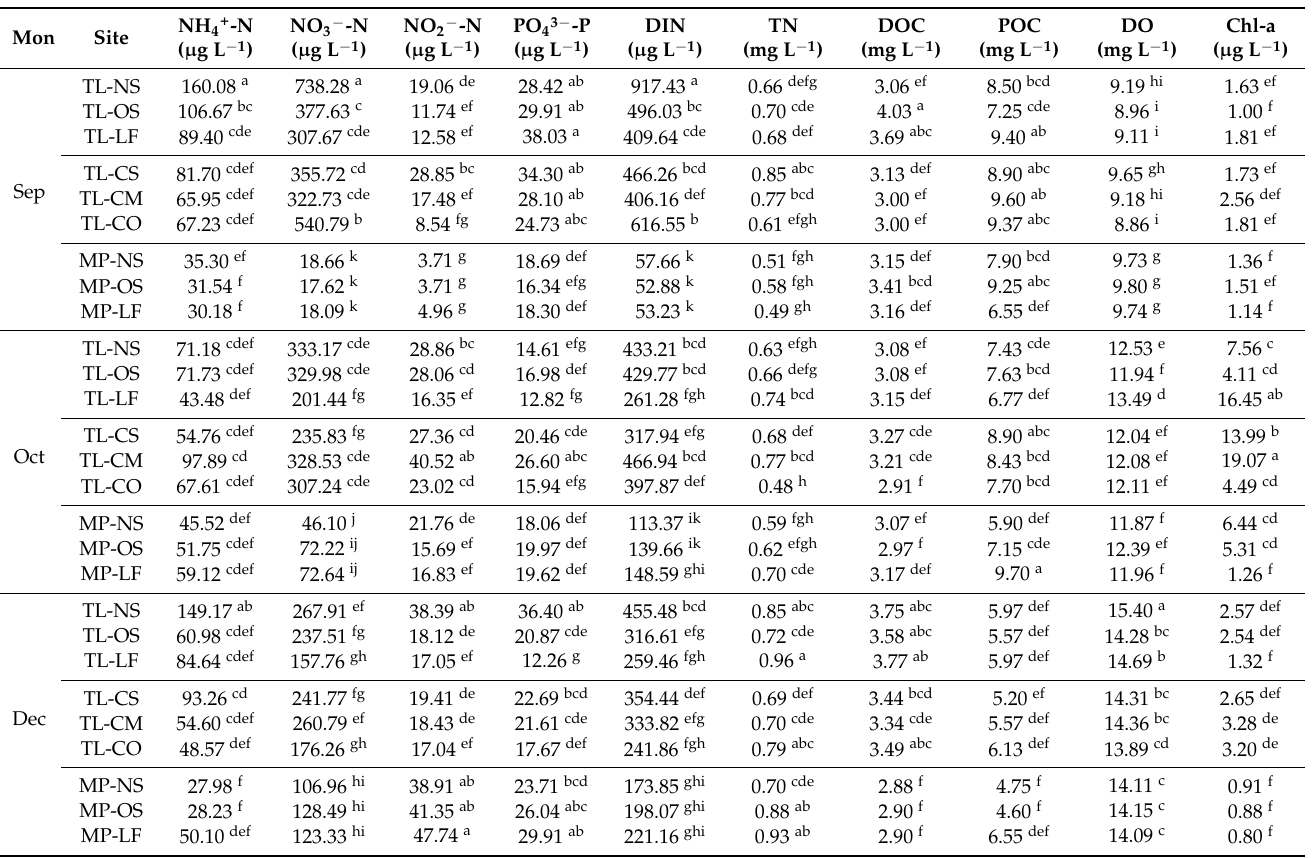
Table 2. The concentrations of hydrochemical parameters for the water samples collected from nine sites in or around two laver farms in Shandong Province, China in September, October, and December 2019. The abbreviations of the sites are the same in Figure 1. The different superscript letters in each column shows that the values are significantly different ( p < 0.05). NH 4+ -N: ammonium